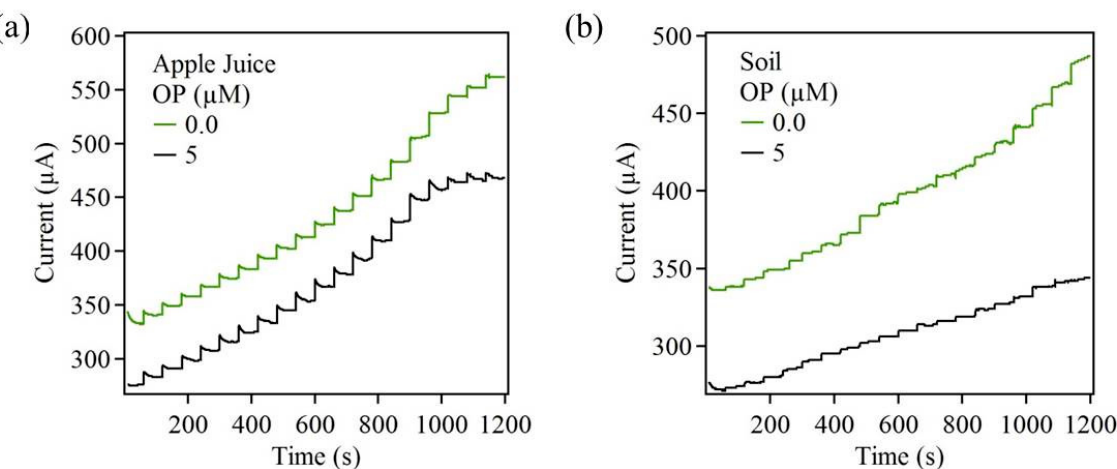
Figure 9. Amperometric response from ZnO + EDA sample on carbon cloth using real samples.